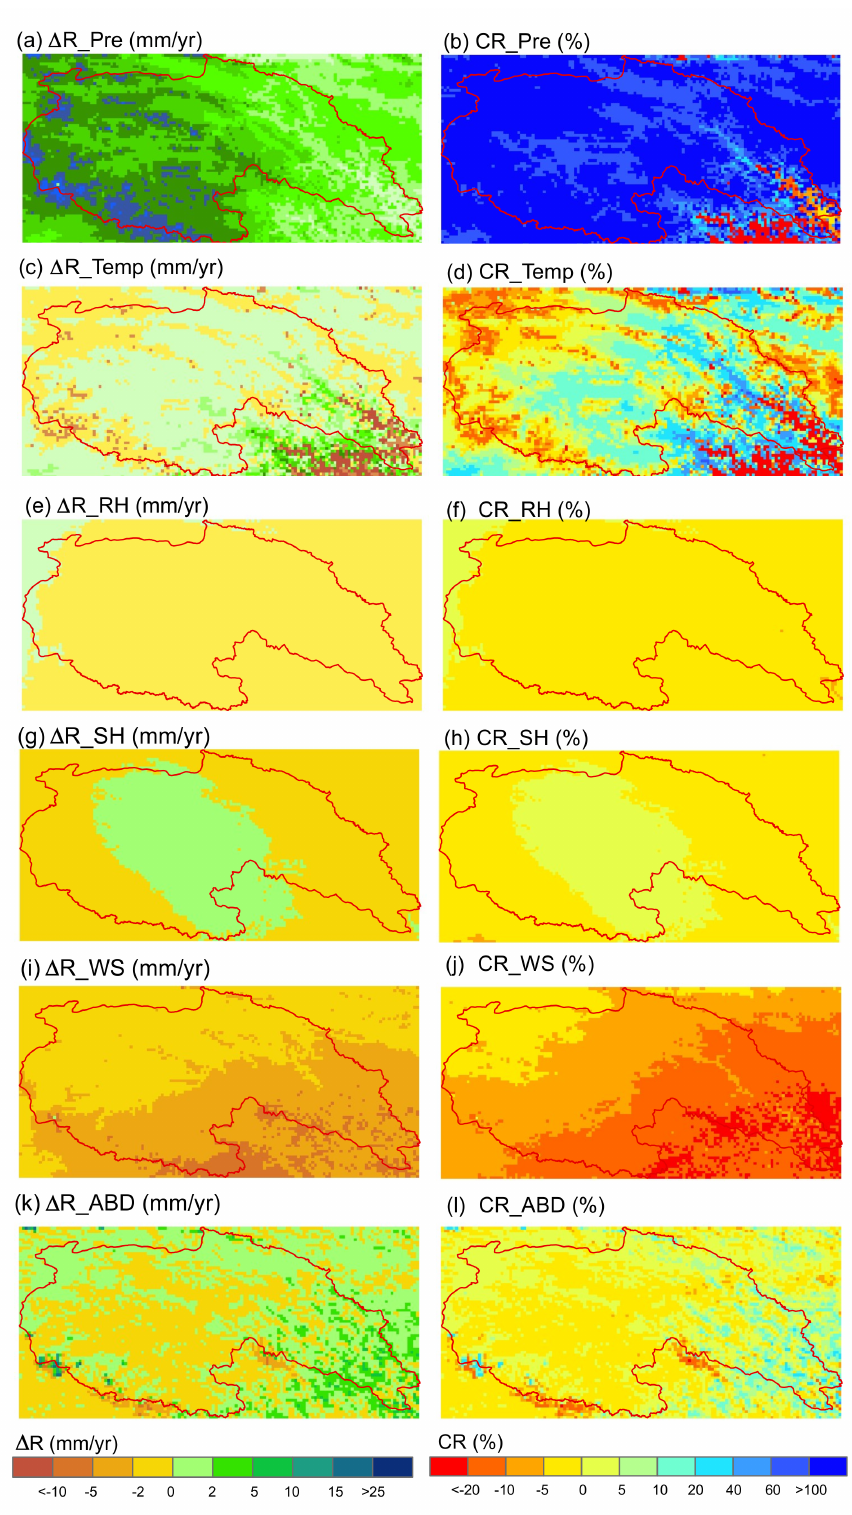
Figure 9. The di ff erence in runo ff simulations obtained from the original and detrended forcing data (left column), and the contribution of each forcing variable to runo ff change (the right column). Unlike Figure 8c, the detrending was only performed for a specific forcing variable. The meaning of abbreviations after “ ∆ R_” or “CR_” are as follows: Pre—precipitation,